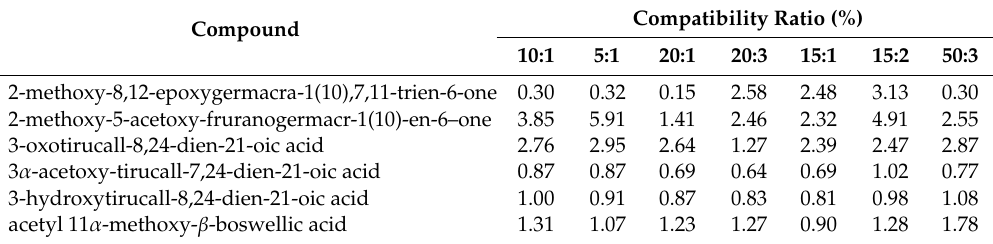
Table 1. Content of compounds with different proportions of BA and MS.